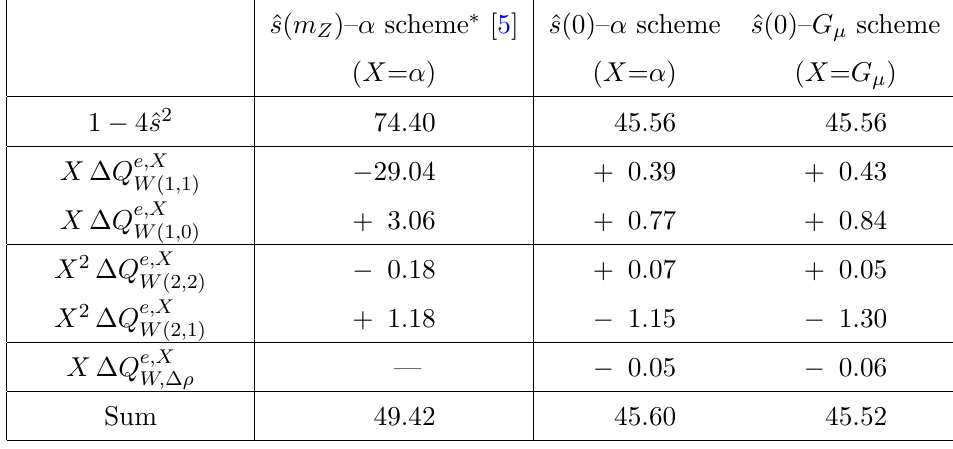
Table 1 . Corrections (in units of 10 − 3 ) at different orders contributing to the electron’s weak charge in polarized Møller scattering in three different input schemes for the SM input parameters in eq. (4.5) and the kinematic parameters s = 0 . 011 GeV 2 and y = 0 . 4 . In our notation, ∆ Q is the contribution at L -loop order from diagrams with n